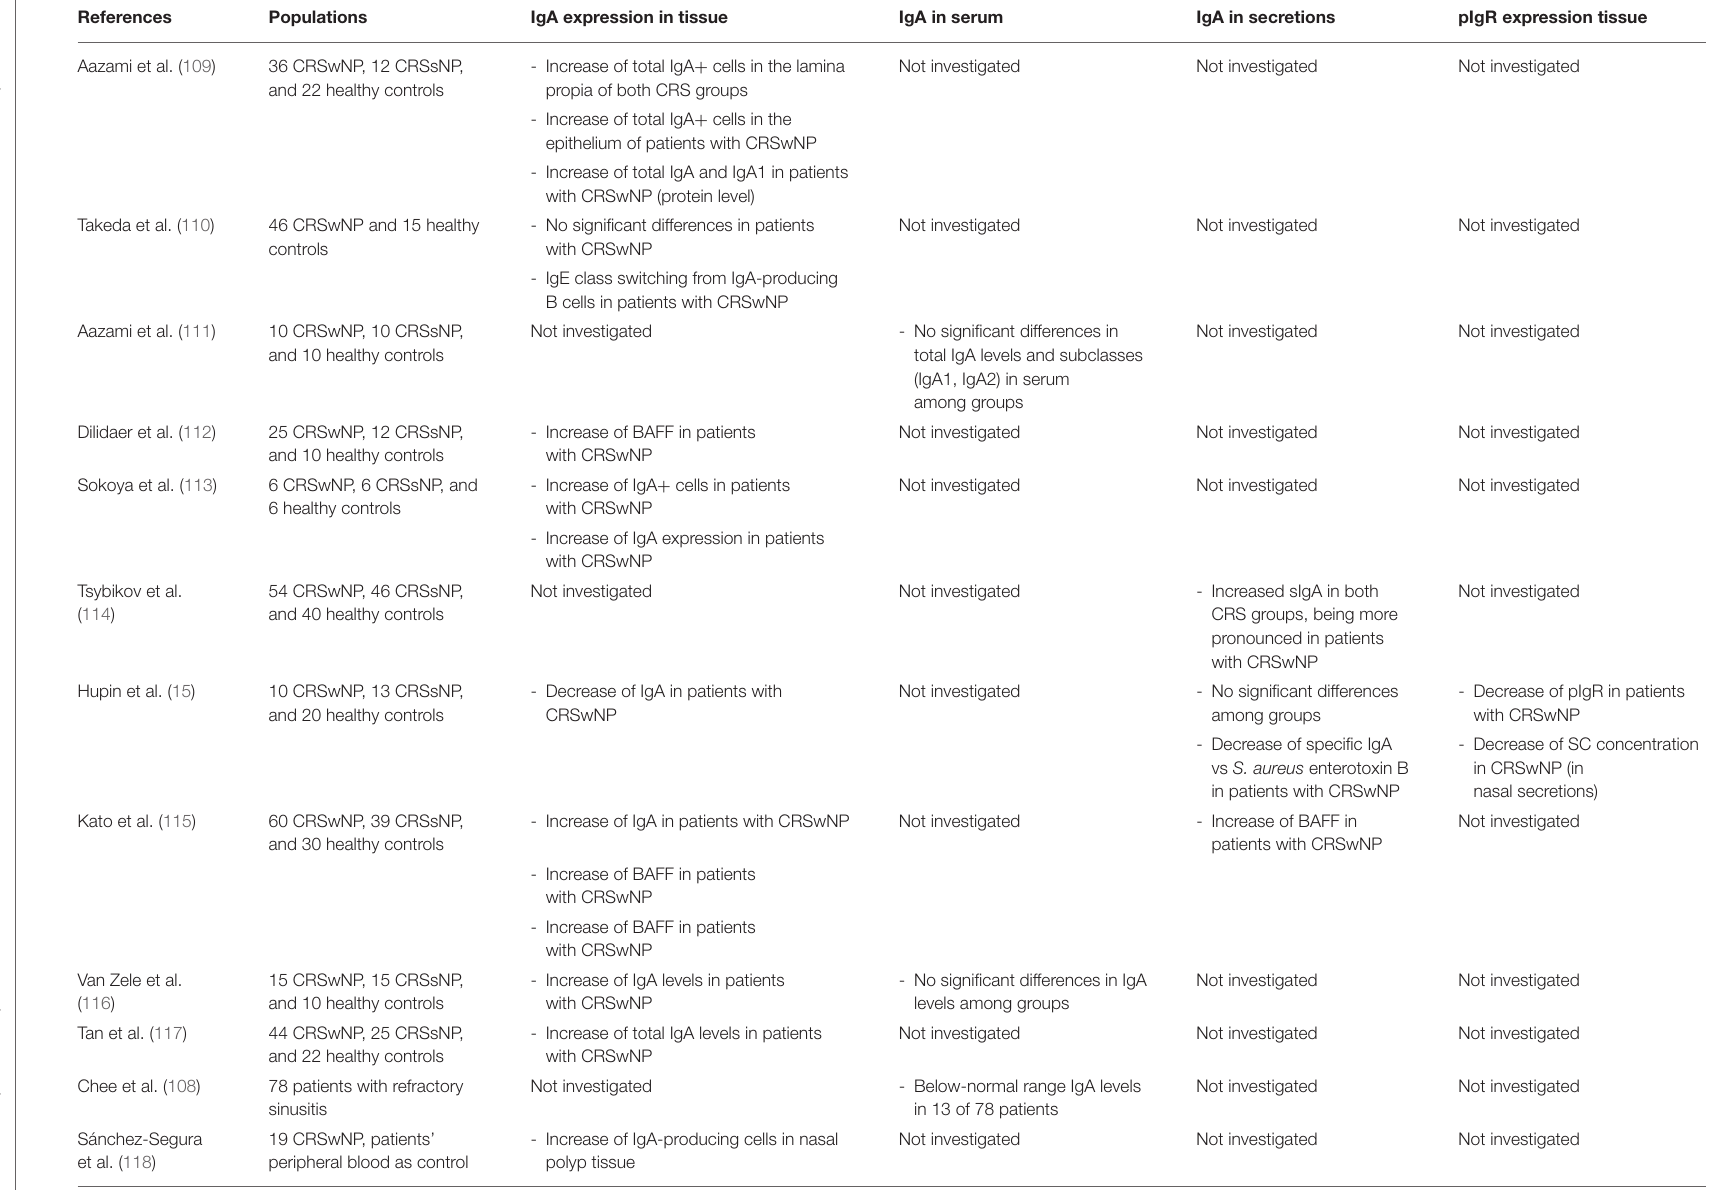
TABLE 1 | Human studies investigating the role of IgA in